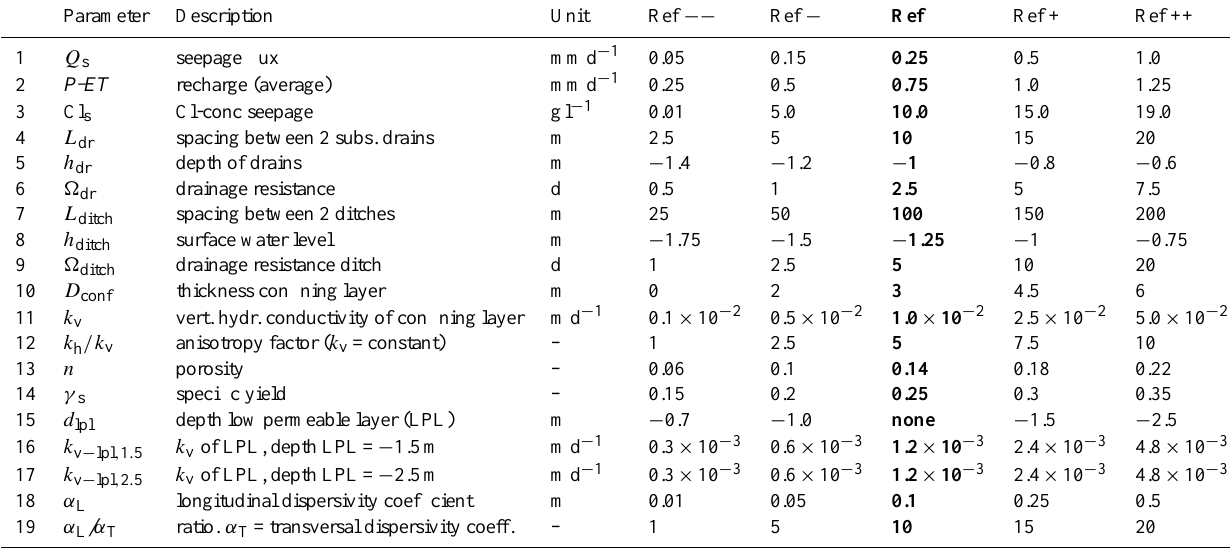
Table 2. Parameter values of the 2-D reference model (Ref) and the sensitivity models (Ref −− , Ref − , Ref+, Ref++).